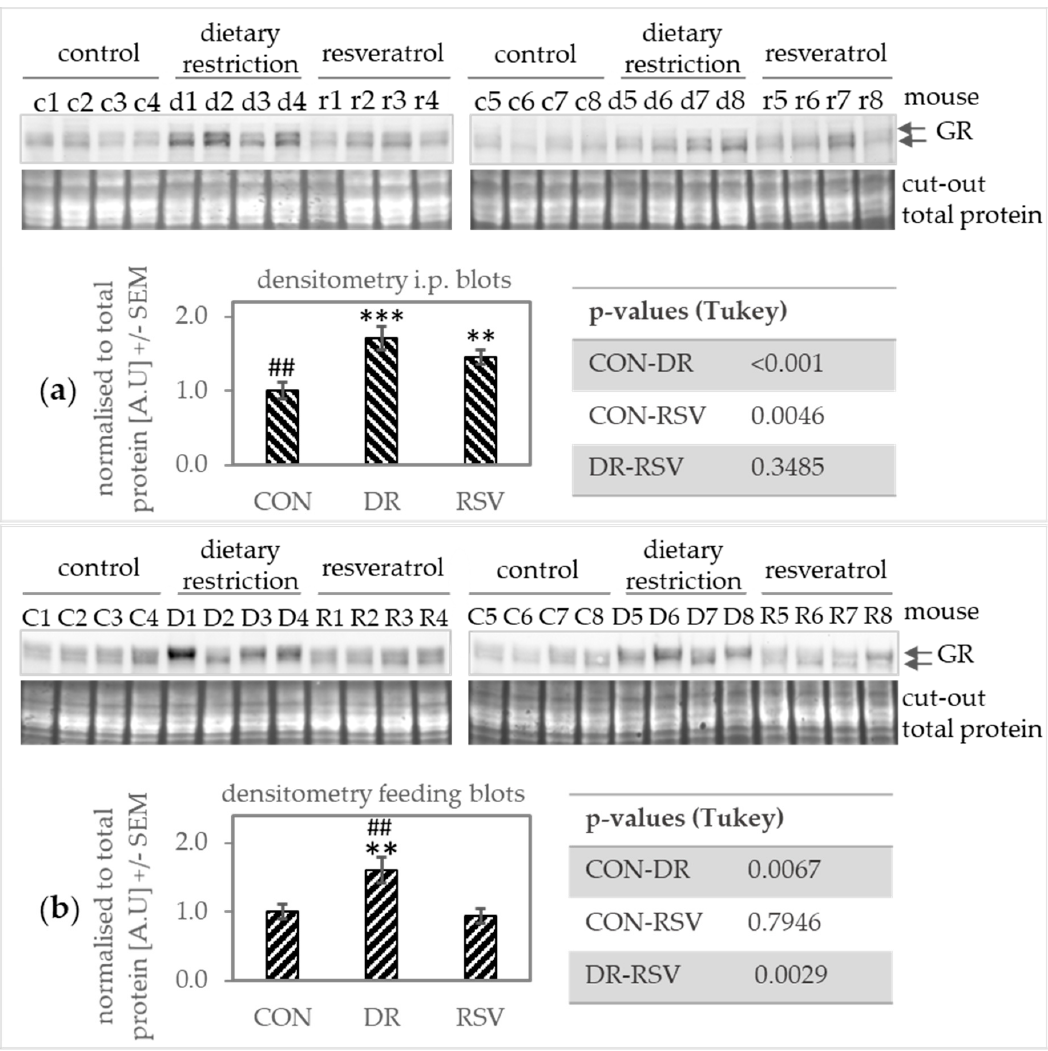
Figure 3. Western blots showing glucocorticoid receptor (GR) levels (double band) in the nuclear fraction of hepatic protein samples from mice supplemented with resveratrol (RSV) compared to ad-libitum control mice (CON) and mice under dietary restriction (CR). ( a ) RSV was injected intraperitoneally, ( b ) RSV was supplemented via diet. GR levels in the nucleus appear to rise upon dietary restriction. Mice from the i.p trial were named with a lower key letter (c—AL control; d—dietary restriction, r—resveratrol), animals from the feeding trial were named with the corresponding upper key letter (C—AL control, D—dietary restriction, R—resveratrol). The number refers to the number given the animal in the trial. Data is presented as mean +/ − SEM. ** p < 0.01 *** p < 0.001 compared to CON; ## p < 0.01 compared to RSV